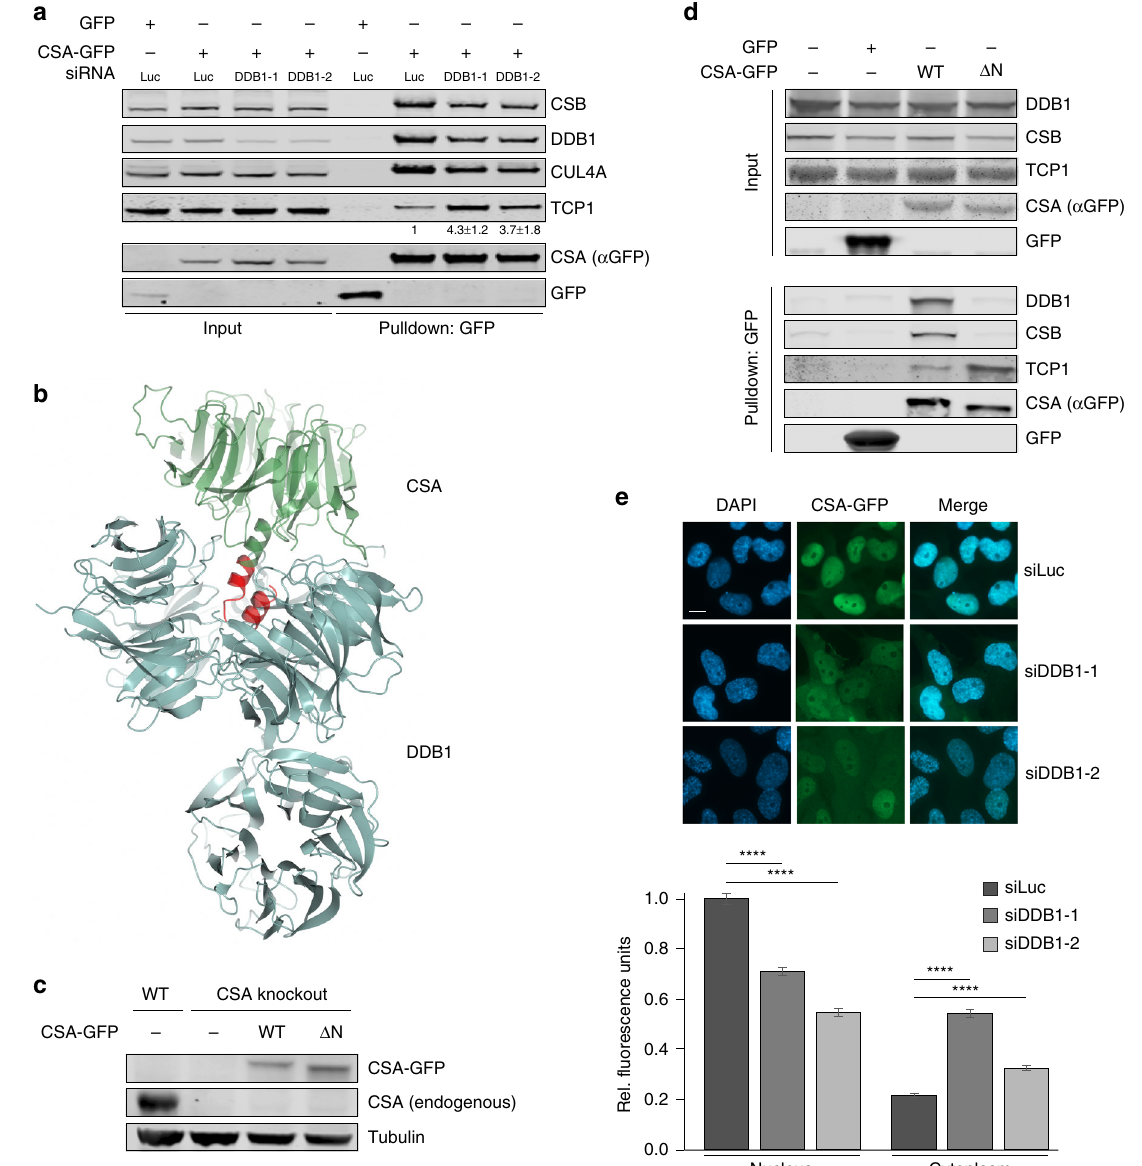
Fig. 4 TRiC is involved in the formation of the CRL CSA complex. a DDB1 loss enhances the interaction between TCP1 and CSA. CSA-GFP was pulled down from CS3BE-SV40 cells treated with the indicated siRNAs. Protein levels were determined by western blot analysis of the indicated proteins. The ratio of TCP1 signal intensities over CSA for siDDB1-treated cells relative to that for siLuc-treated control cells, which was set to 1, is shown as the mean ± SEM of three independent experiments. b Overall structure of CSA (green) bound to DDB1 (blue), showing that CSA ’ s N-terminus is directly involved in DDB1 binding. CSA Δ N lacks amino acids 1 – 21, which are shown in red. Visualization was done in ccp4mg using structure 4a11 from the PDB. Length of scale bar: 10 µ m. c Stable expression of CSA-GFP WT or CSA-GFP Δ N in CSA knockout U2OS. Protein levels were determined by western blot analysis of the indicated proteins. Tubulin is a loading control. d Deletion of CSA ’ s DDB1-interacting domain leads to increased TRiC binding. Stably expressed GFP-NLS, CSA-GFP WT, and CSA-GFP Δ N were pulled down from CSA knockout U2OS cells as indicated. e DDB1 decreases CSA-GFP protein abundance in the nucleus concomitantly with an increase in cytoplasmic localization. DDB1 was depleted from CSA-GFP expressing CS3BE-SV40 cells using the indicated siRNAs. Nuclear and cytoplasmic CSA-GFP levels were analyzed and quanti fi ed by fl uorescence microscopy and ImageJ. GFP signal intensities were normalized to the average nuclear signal in siLuc-treated cells. Data represent mean ± SEM of 190 cells quanti fi ed in two independent experiments. p - Values were derived from an unpaired t -test. Full-size scans of western blots are provided in Supplementary Fig.